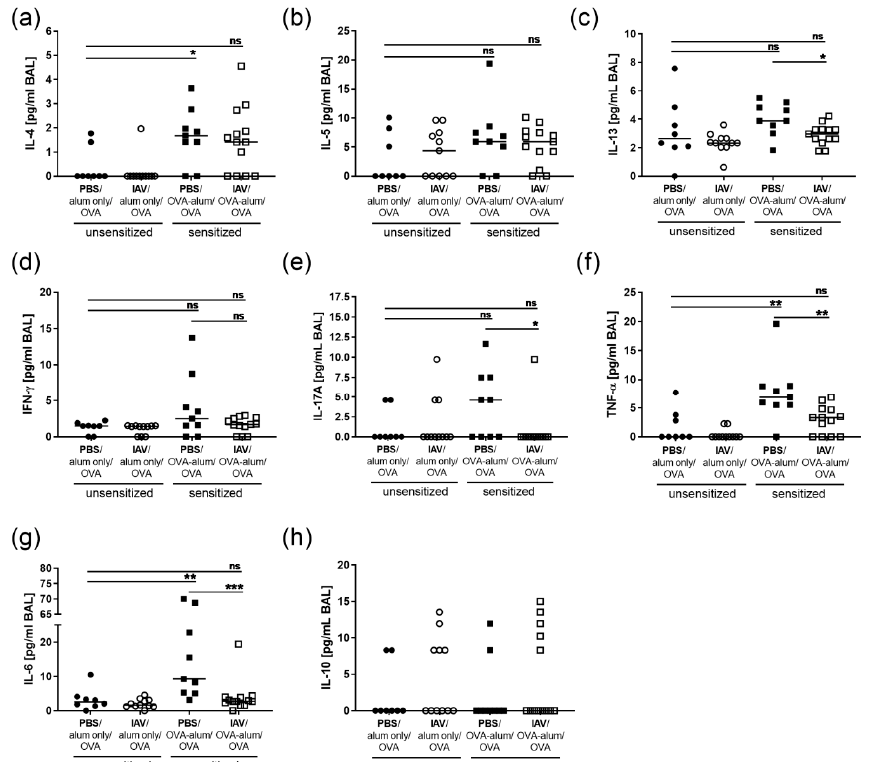
Figure 7. Resolved IAV infection significantly inhibits the pro-inflammatory cytokine response in AAI. Mice were infected i.n. with a sublethal dose of IAV or treated with PBS on day 0, were sensitized against OVA i.p or mock-sensitized with alum only i.p. on days 14, 21 and 28 and all mice were challenged i.n. with OVA on days 35, 36 and 37. On day 39 post infection, BAL levels of IL-4 ( a ), IL-5 ( b ), IL-13 ( c ), IFN- γ ( d ), IL-17A ( e ), TNF- α ( f ), IL-6 ( g ) and IL-10 ( h ) were analyzed. Data are shown for individual mice together with the group median. BAL samples were collected in three independent experiments. * p < 0.05, ** p < 0.01, *** p < 0.005, ns = not